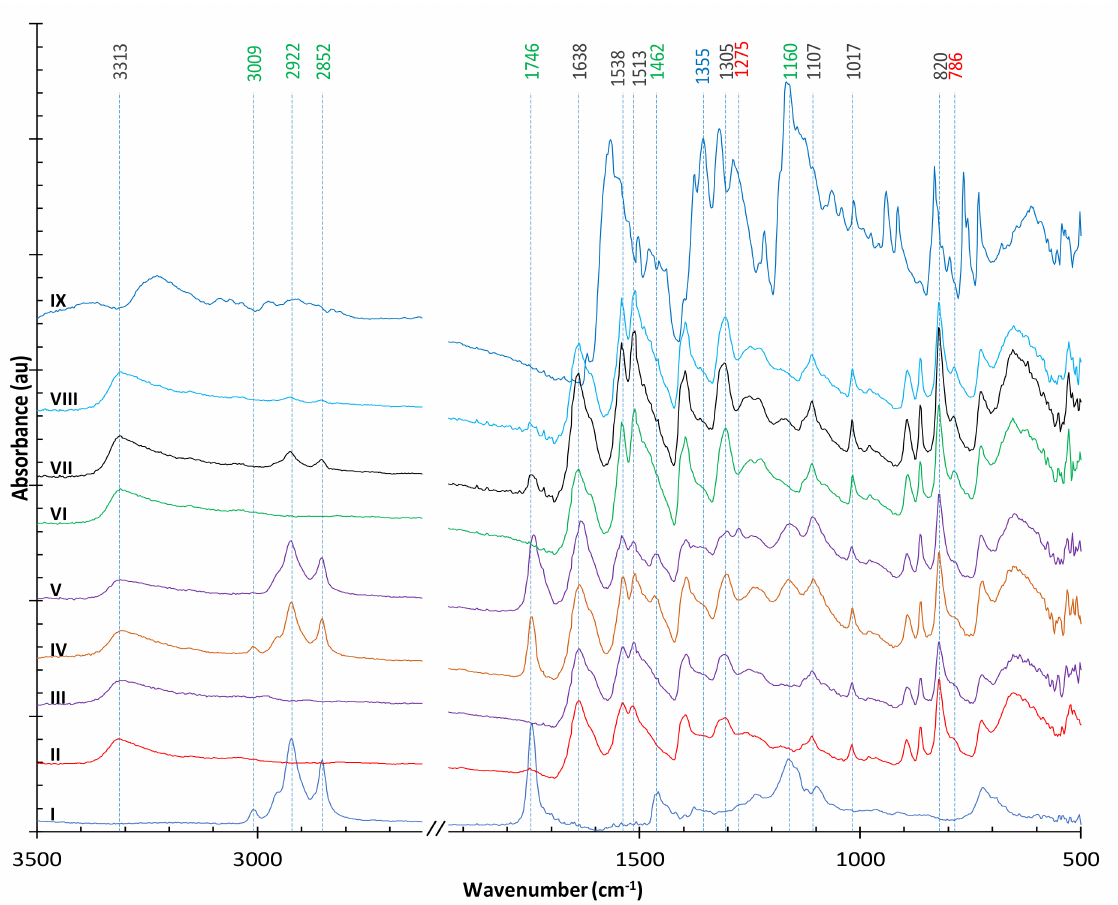
Figure 9. FTIR spectra of the para-aramid fabrics, materials and after certain treatments as follows: ( I ) Soybean oil; ( II ) Para- aramid fabric (untreated); ( III ) Para-aramid fabric treated with NTP; ( IV ) Para-aramid fabric after soaking in soybean oil; ( V ) Para-aramid fabric after soaking in soybean oil followed by a subsequent NTP treatment; ( VI ) Para-aramid fabric dyed with NTP as the only pretreatment; ( VII ) Para-aramid fabric dyed after soaking in soybean oil (without an NTP treatment); ( VIII ) Para-aramid fabric dyed after soaking in soybean oil and an NTP treatment; and ( IX ) Victoria Blue R cationic dye. The spectrum of untreated para-aramids (line II) has main peaks at 3313 cm − 1 (–N–H The absorption bands at 1513 cm − 1 (amide II), at 1017 cm − 1 and at 820 cm − 1 deriving from the C–H bonds on the para-aromatic rings and the absorption band at 1305 cm − 1